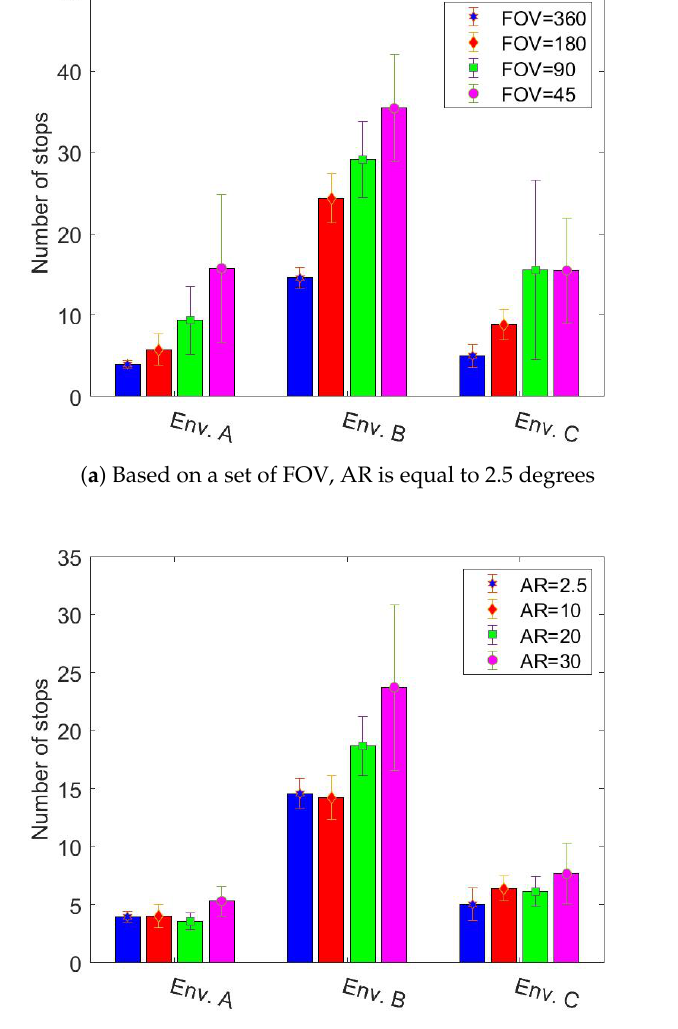
Figure 15. The number of stops required for the gamma camera to give a radiation image in MCDM, average over ten trials.